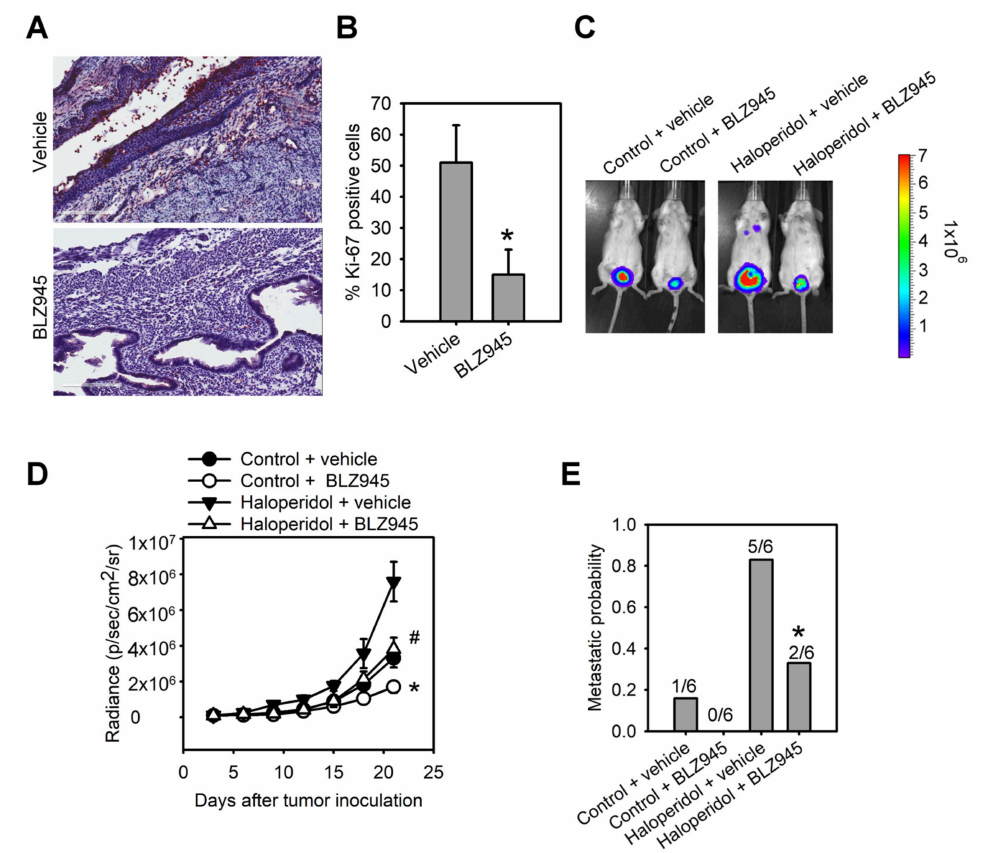
Figure 6. Blockage of CSF-1/CSF-1R inhibits haloperidol-promoted endometrial hyperplasia and malignant progression of EC in vivo. Ki-67 immunohistochemistry ( A ) and its quantification ( B ) in uterine tissues from adult C57BL/6J mice receiving chronic treatment of vehicle or haloperidol (2 mg/kg/day) plus BLZ945 (200 mg/kg/day) for 28 days. Bar = 200 µ m. ( C ) Bioluminescent images of the HEC1A-lucGFP bearing mice, which either received treatments of vehicle, BLZ945 (200 mg/kg/day for 21 days), haloperidol (2 mg/kg/day for 21 days) plus vehicle, or haloperidol (2 mg/kg/day for 21 days) plus BLZ945 (200 mg/kg/day for 21 days) on day 21 after tumor implantation. ( D ) Longitudinal monitoring of the tumor growth via BLI signal intensities for each group of treatments in ( C ). ( E ) The metastatic probabilities for each group of treatments in ( C ). Data are presented as means ± SD (n = 6). * p < 0.01 compared to the vehicle’s group (normal saline). # p < 0.001, compared with the vehicle’s group (normal